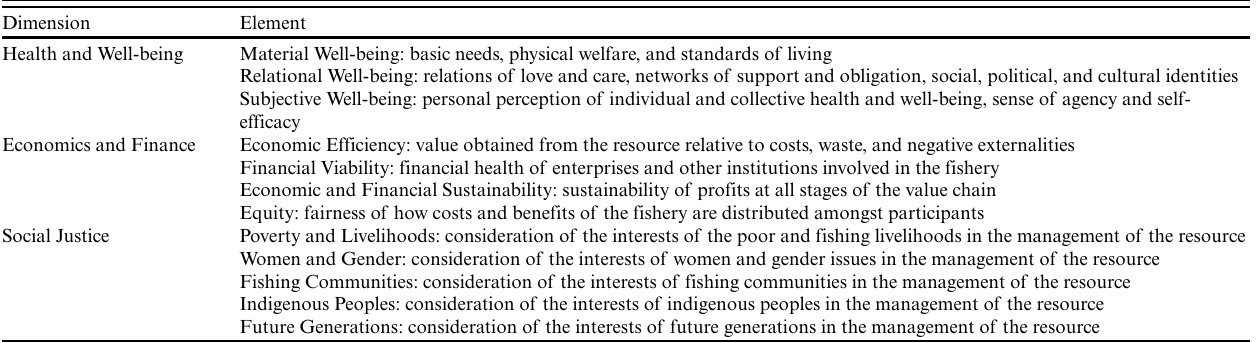
Table 3 . Elements in the social and economic domain.